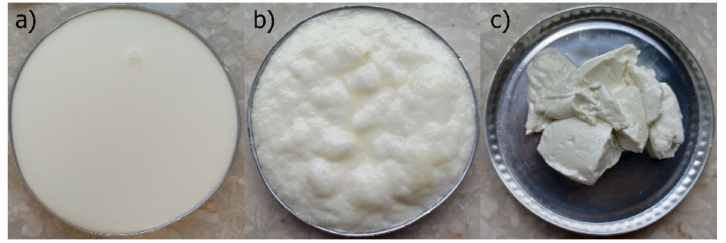
Figure 1. Stages of oleogel formation: ( a ) emulsion, ( b ) oleogel after drying, and ( c ) oleogel after